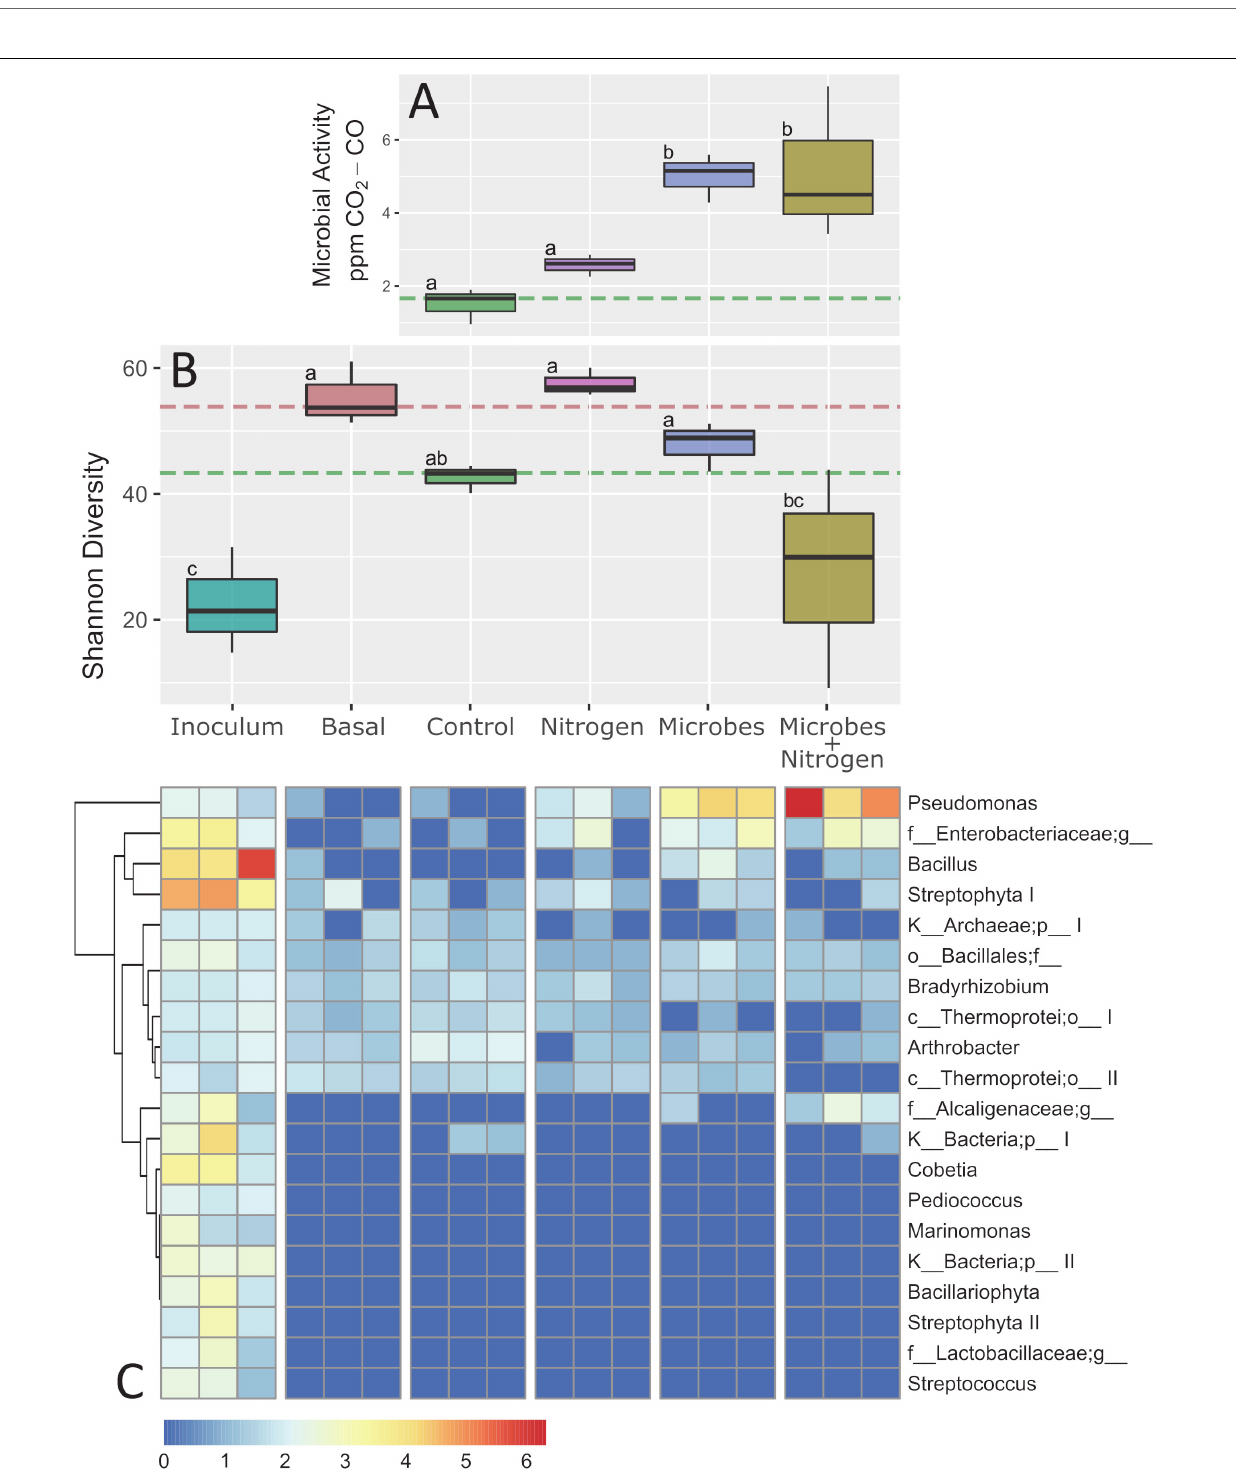
FIGURE 3 | Composite figure showing microbial response, at physiological, ecological, and compositional levels, to treatments used in this study. (A) Shows microbial physiological activity, proxied as soil respiration changes. (B) Denotes Shannon diversity index of samples including SMI and pre-incubated levels (treatment Basal). Orange and green segmented lines represent basal and controls levels as per in Figure 1 . (C) Heatmap represent the top-20 most abundant OTUs found in SMI samples as a way to track-down the fate of those allochthonous microorganisms in a semi-arid ecosystem. Boxplot sharing same letter coding are significantly similar ( p ≤